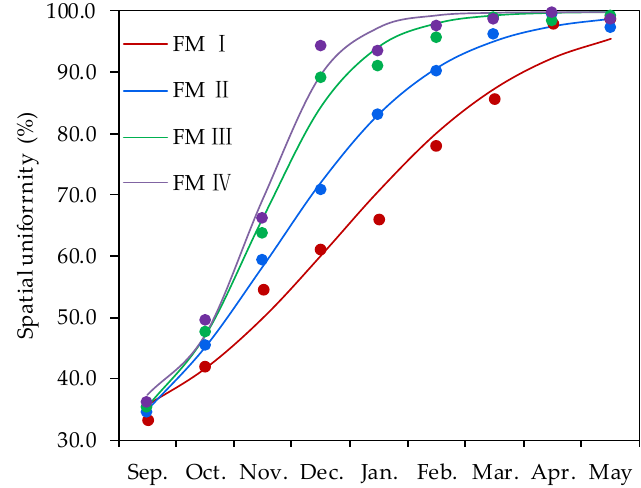
Figure 7. Effects of field margins (FM) size classes on the earthworm population spatial uniformity of arable field (AF) of the rice-rapeseed system under rotary tillage from September 2016 to May 2017. The logistic regression model Y = 1 − k/[1 + EXP(a − bx)] was applied to simulate the spatial uniformity in time series.